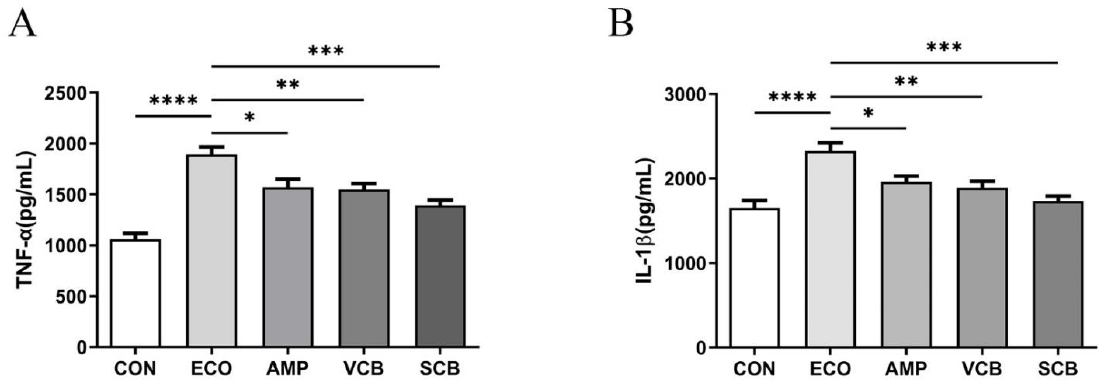
Figure 3. C. butyricum and its culture supernatant reduced the production of pro-inflammatory cy- tokines in uterine tissues induced by E. coli . ( A ) Uterine tissue TNF- α . ( B ) Uterine tissue IL-1 β . The values presented are the means ± SEM ( n = 6). * p < 0.05, ** p < 0.01, *** p < 0.001, and **** p < 0.0001 are significantly different from the ECO group.